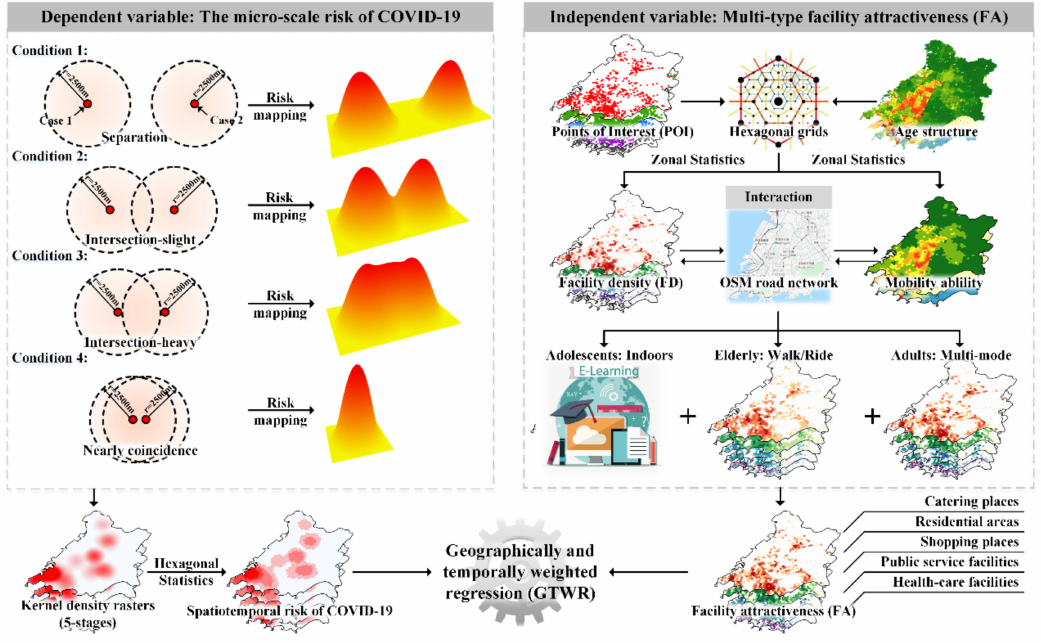
Figure 3. The overall workflow diagram of this empirical modeling